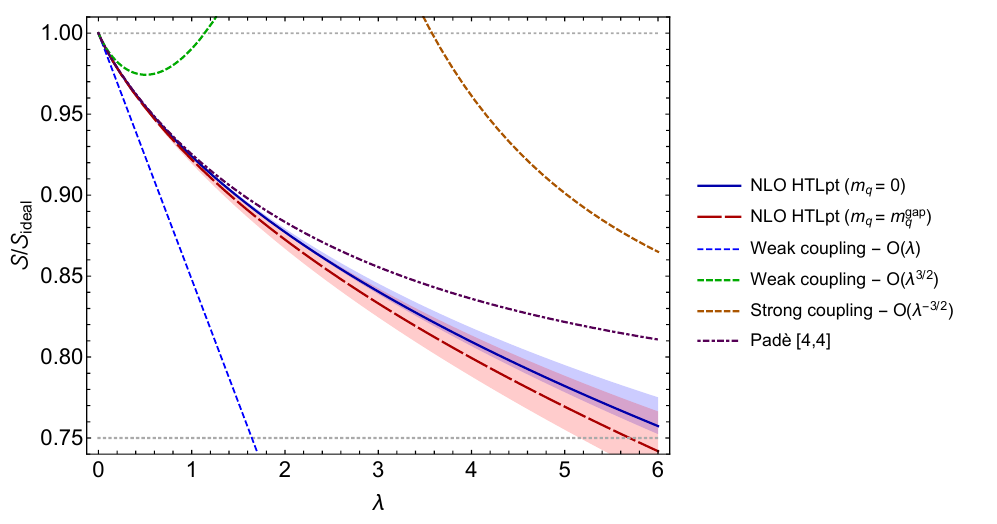
Figure 10 . Comparison of two di(cid:11)erent quark mass prescriptions: m q = 0 and m q = m gap NLO HTLpt results with these prescriptions are shown as solid blue and long-dashed red lines, respectively. We also include plots of the results obtained in the strong and weak coupling limits along with the [4,4] Pad(cid:19)e